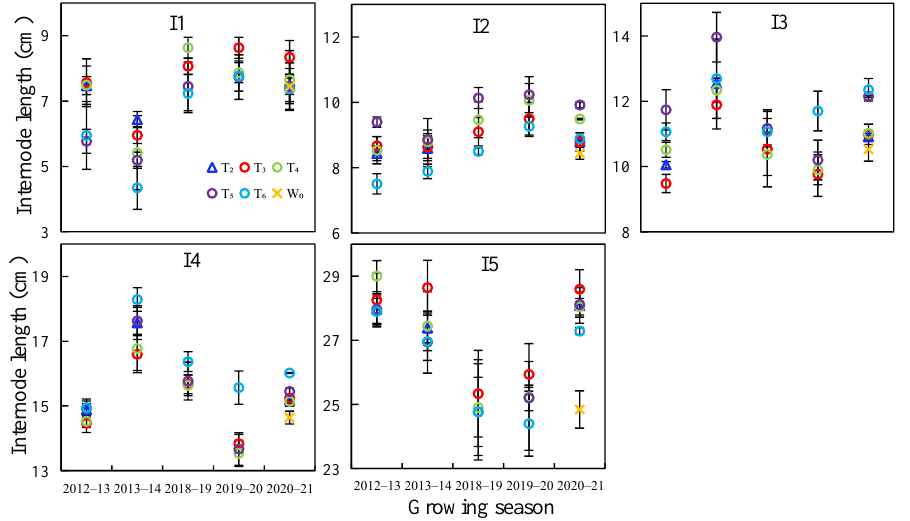
Figure 6. Internode length for different treatments in each wheat growing season. I1 – I5 represent